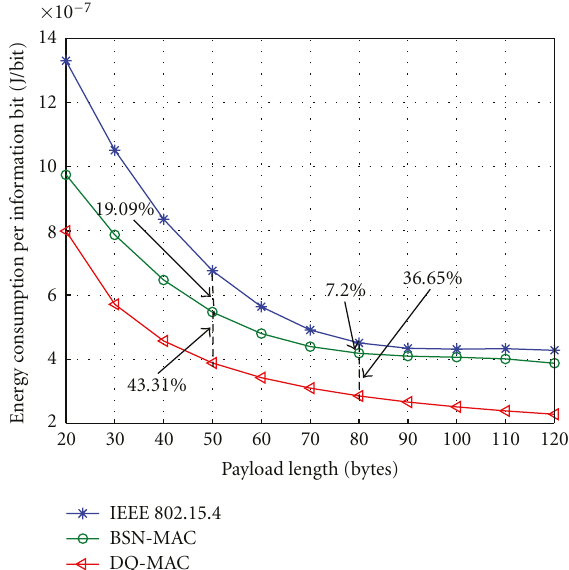
Figure 6: Analytical energy consumption per information bit (high-density area).